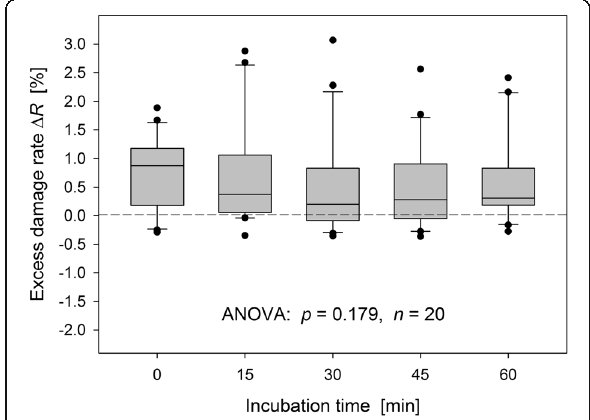
Fig. 7 Excess damage rates determined for lymphocytes fixed and isolated from blood samples withdrawn 60 min post [ 18 F]FDG injection (SP3) that were subsequently incubated up to 60 min (Friedman test). Data were pooled over SA1 and